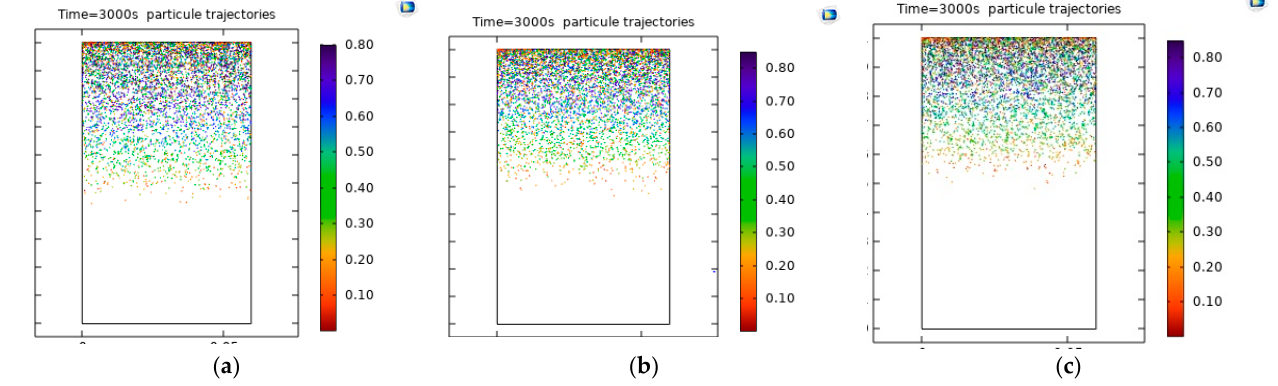
Figure 13. Two-dimensional (2D) distribution and velocity of particles inside the reactor at 3000s: Effect of the imposed wall thermal power, ( a ) q 0 = 2.0 kW; ( b ) q 0 = 2.3 kW; ( c ) q 0 = 3.0 kW.